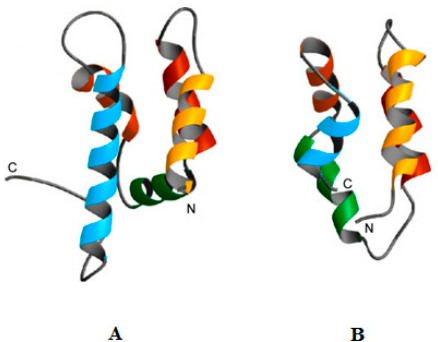
Figure 2. Similarities between the structures of psoriasin and amoebapore A. Figure 2 was revised from [35] and shows human psoriasin ( A ) and amoebapore A from the protozoa, Entamoeba histolytica ( B ). It can be clearly seen that these peptides show structural similarities and both have been shown to possess pH dependent mechanisms of antimicrobial activity that is enhanced by acid conditions [34–36,79–81,83]. In particular, psoriasin possesses a histidine residue in its C-terminal region [127] similarly to amoebapore A [82] and based on these similarities, it can be speculated that the enhanced antibacterial action of psoriasin at low pH may involve a histidine mediated increased ability for pore formation and oligomerisation.